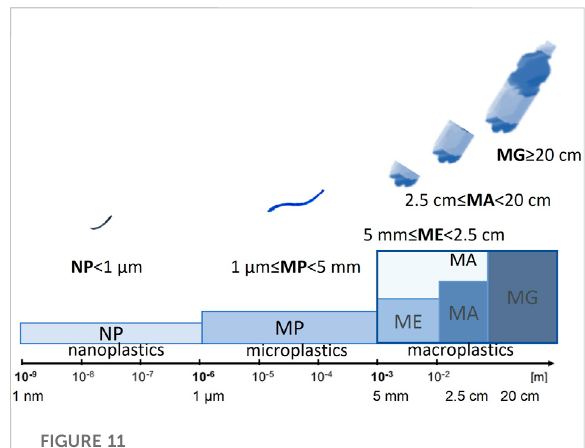
FIGURE 11 New nomenclature proposal of plastic classi fi cation